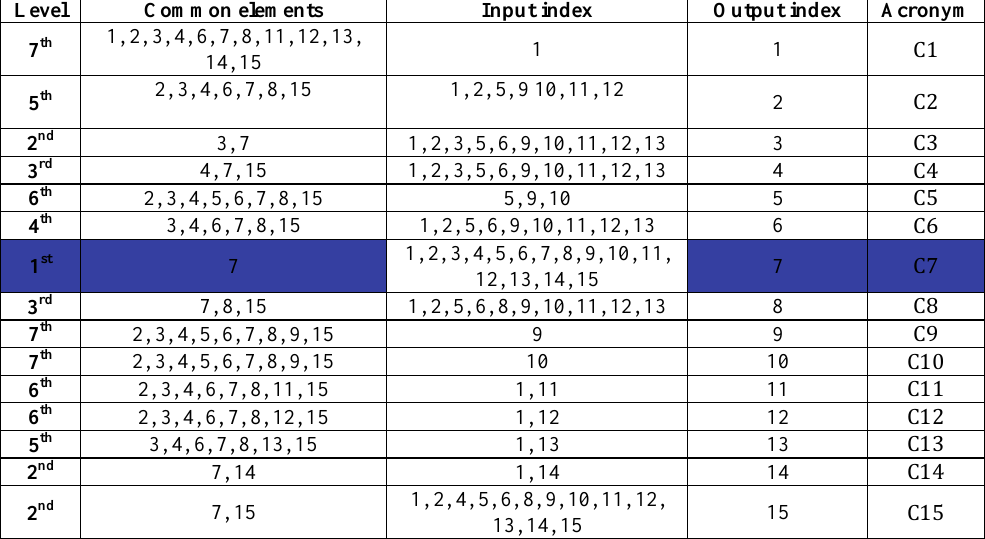
Table 13. Set of the input/output indices and the common elements of the